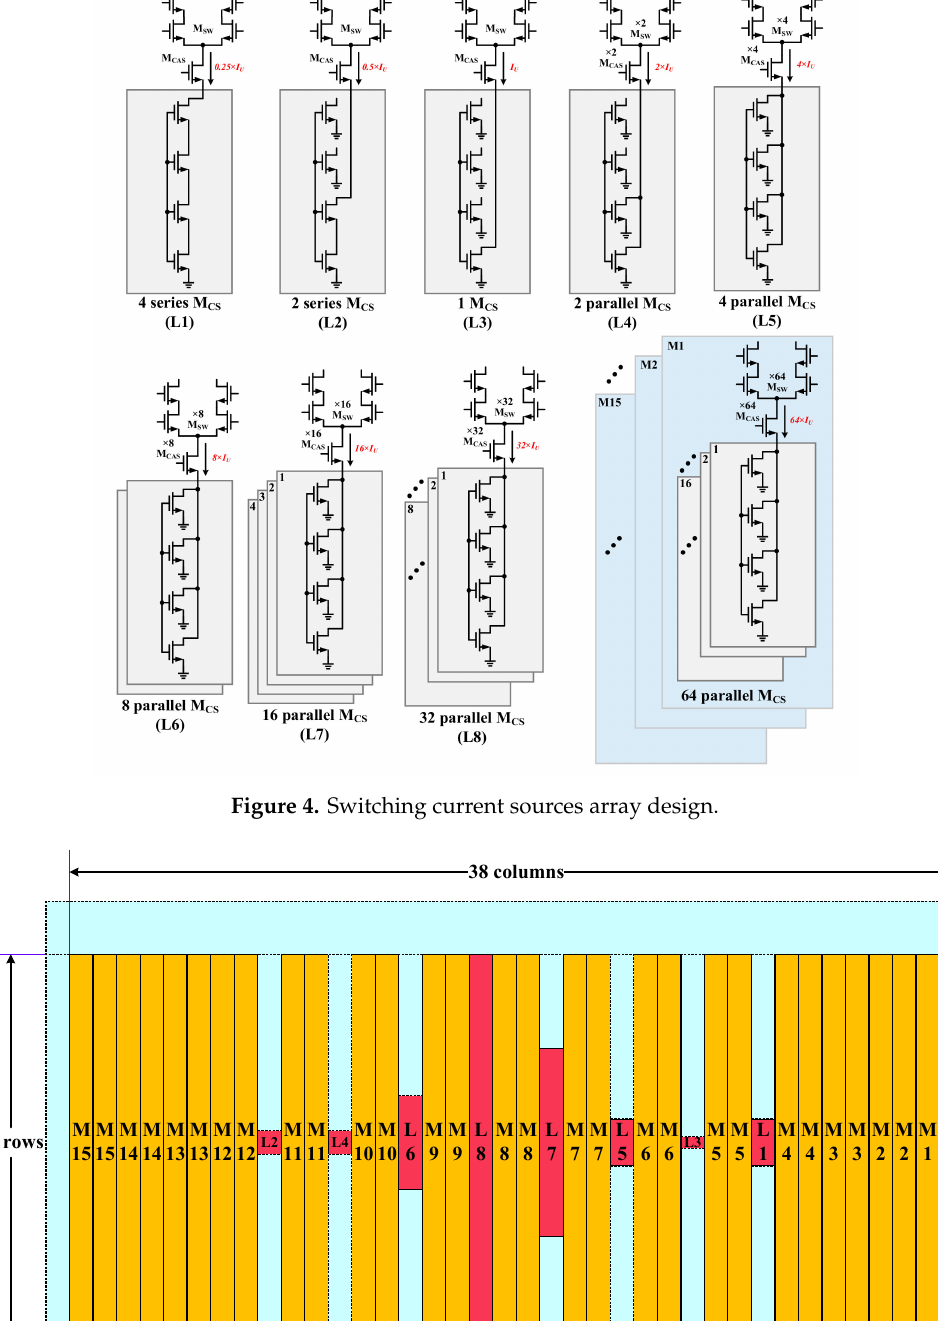
Figure 5. Current sources array layout floorplan.